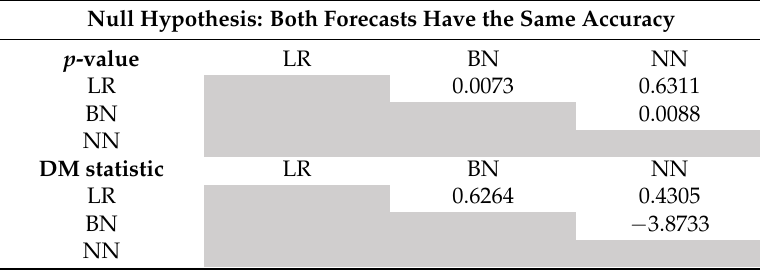
Table 3. DM-test results for all forecasting models, carried out in